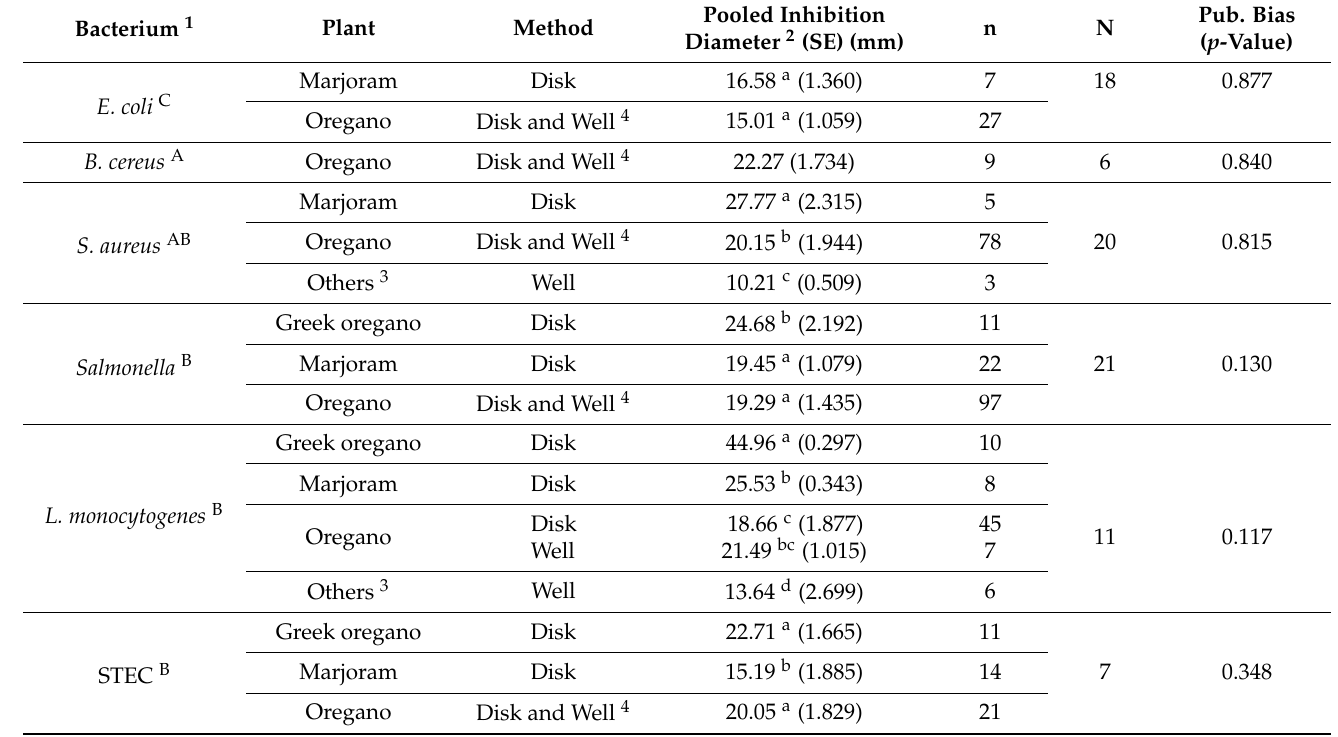
Table 2. Pooled inhibition diameters (mean and standard error, SE, in mm) of Origanum species extracts against specific bacteria using meta-analysis models. Number of observations (n), number of primary studies (N), and p -value of the publication bias test are presented for each